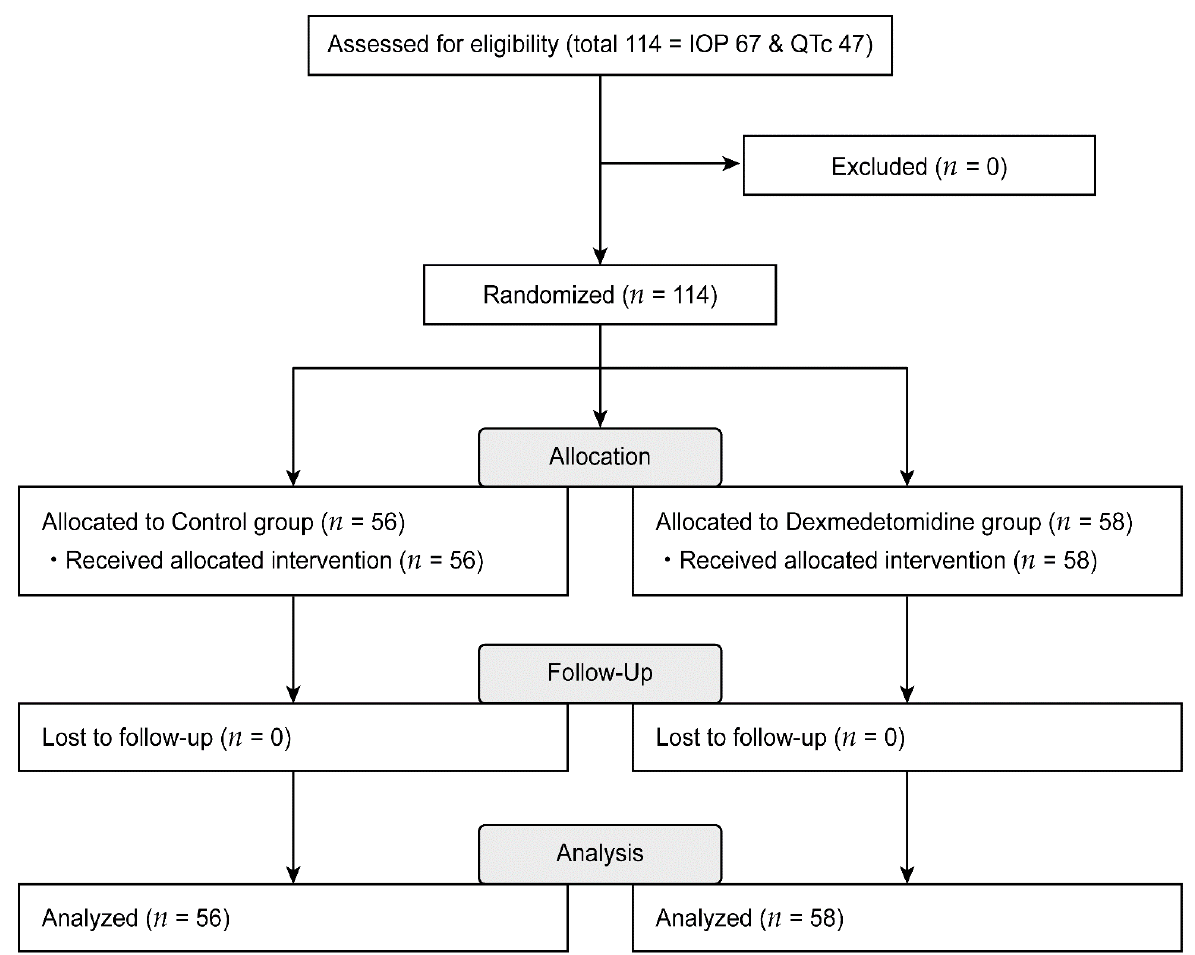
Figure 1. Consort flow diagram. IOP = intraocular pressure; QTc = heart-rate corrected QT interval. There were no significant between-group differences in the demographics and oper- ative variables, except for the administered remifentanil dose (Table 1); the intraoperative administered dose of remifentanil was significantly lower in the dexmedetomidine group than in the control group (492 ± 169 vs. 731 ± 269 μ g; p < 0.001).